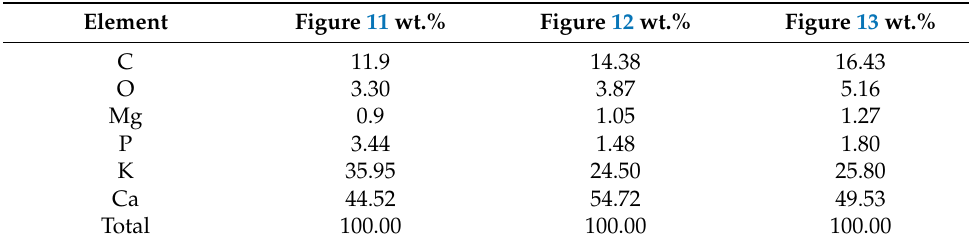
Table 7. Elemental analysis of wood biochar at specific regions. Element